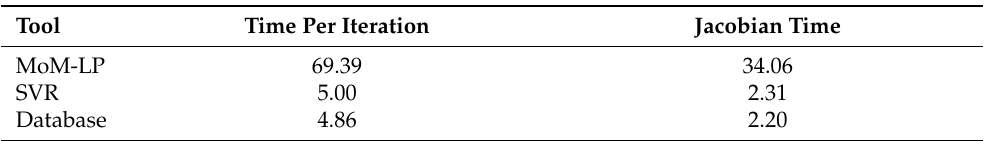
Table 4. Computing time performance of the direct layout optimization considering three different tools for the analysis of the reflectarray unit cell. Time is in seconds. Tool Time Per Iteration Jacobian Time MoM-LP 69.39 34.06 SVR 5.00 2.31 Database 4.86 2.20